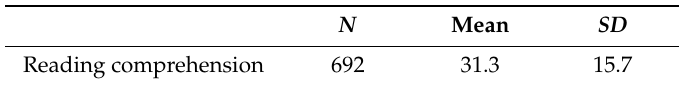
Table 1. Descriptive statistics for the Suffolk Reading Scale 2 (SRS2). Reading comprehension descriptive statistics.